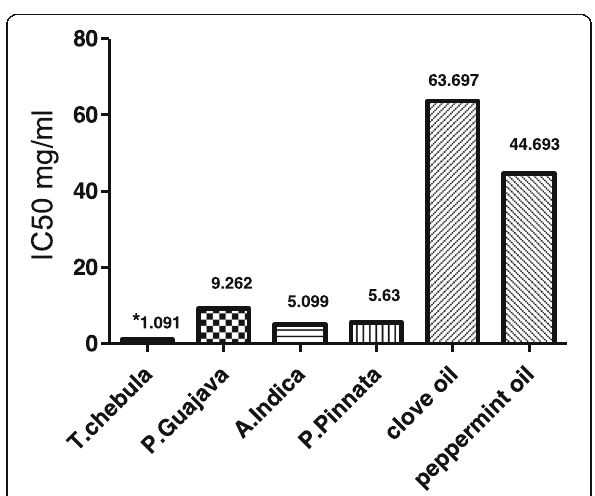
Fig. 3 IC50 values of plant extracts and essential oils